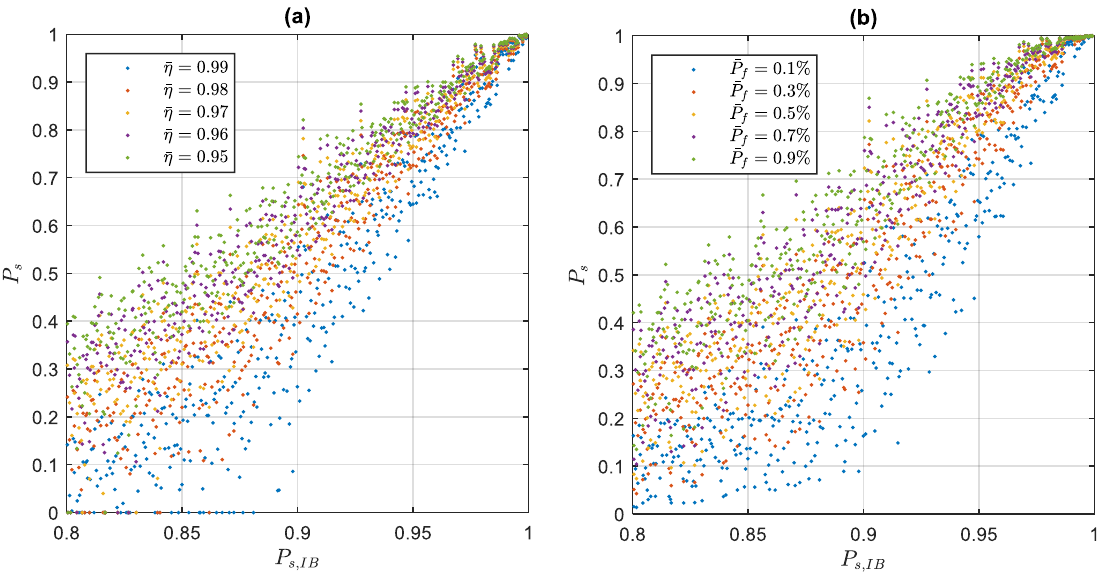
Figure 7. The success rate of the FL-approach ( a ) and the FF-approach ( b ).